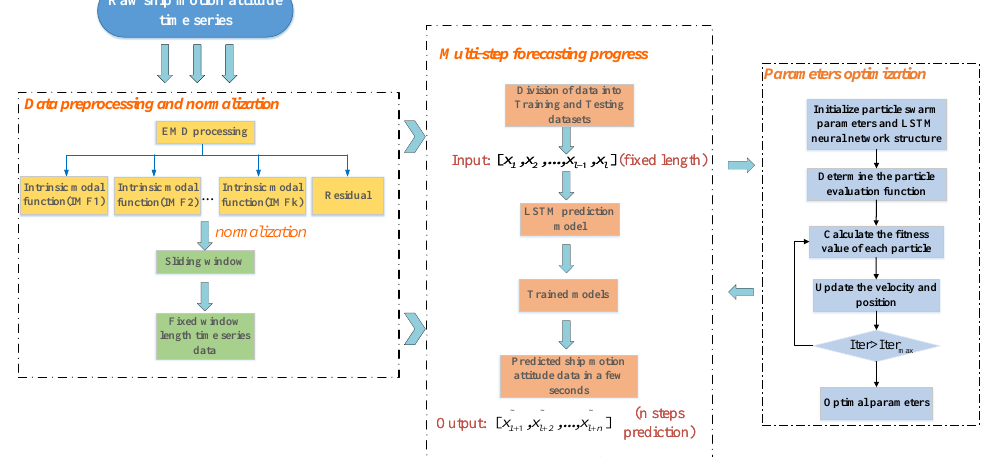
Figure 4. The overall structure of the proposed hybrid prediction model.